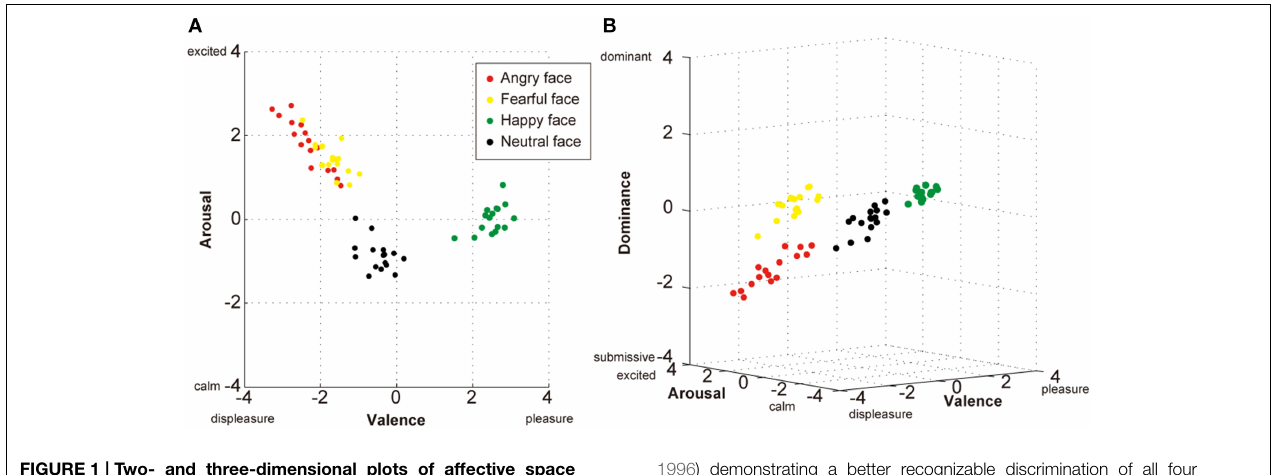
1996) demonstrating a better recognizable discrimination of all four facial expressions. Each plot shows the average evaluation ( n = 122 participants) of each stimulus (16 stimuli × four expressions). Watanabe et al. (2012) investigated the effect of a single nucleotide polymorphism (SNP) in Neuropeptide B/W receptor 1 (NPBWR1); however, the present data plots disregarded the different SNP types to better describe the general tendencies of perceived emotion from the four types of facial